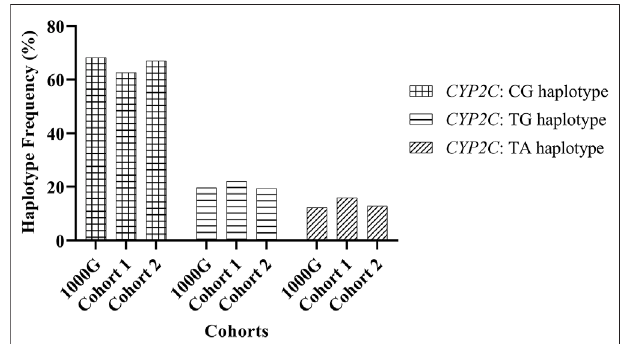
FIGURE 1 | Frequency of CYP2C :haplotypes inferred from genetic variations rs2860840 C > T and rs11188059 G >